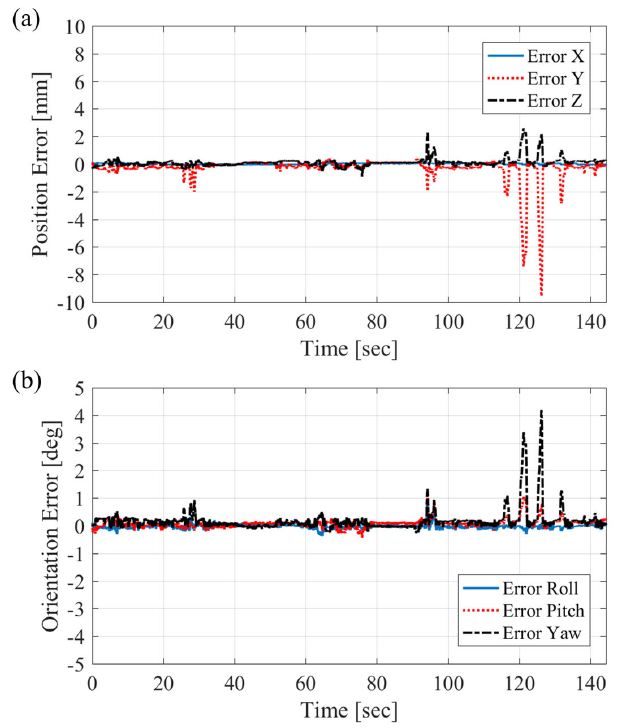
Figure 13. Error of the optimization path generator: ( a ) position error; ( b ) orientation error.